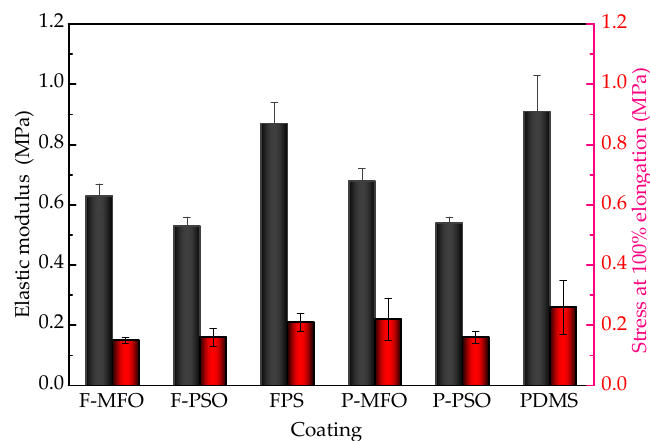
Figure 8. Elastic modulus and stress at 100% elongation of studied coatings.